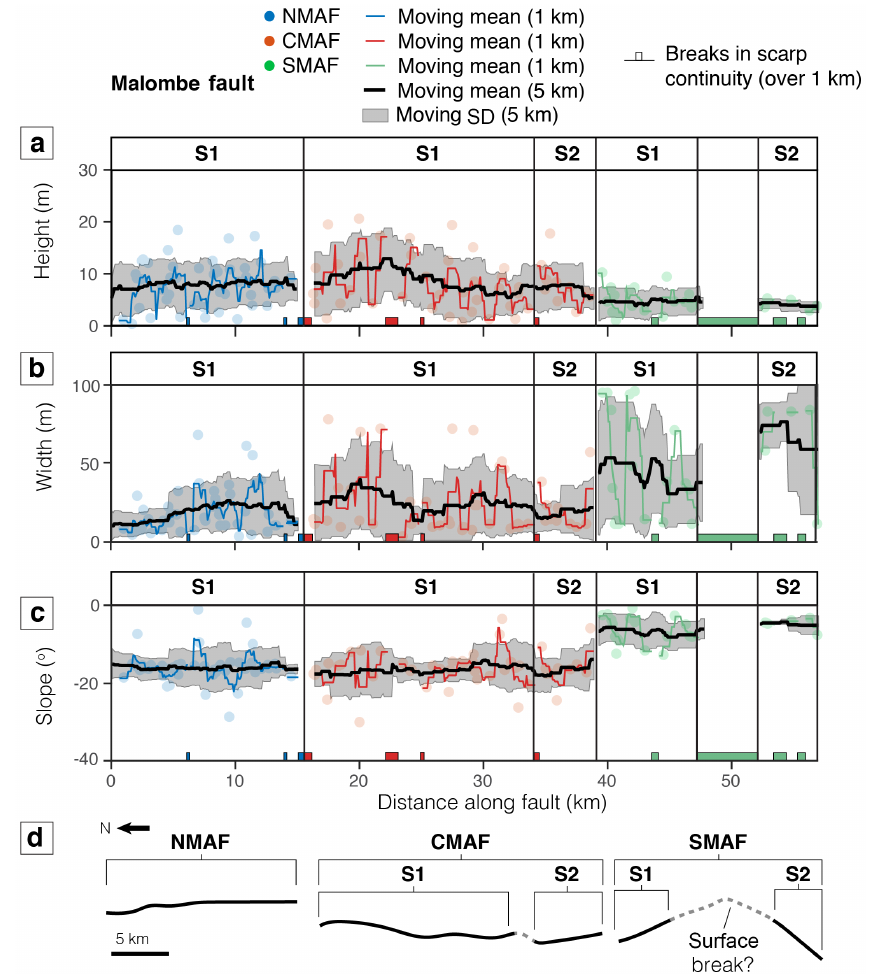
Figure 13. Panels (a) – (c) show the height, width and slope profiles for the Malombe fault scarps using the TanDEM-X DEM. (d) A map view showing fault structural segmentation, breaks in scarp and the location of inferred linkage